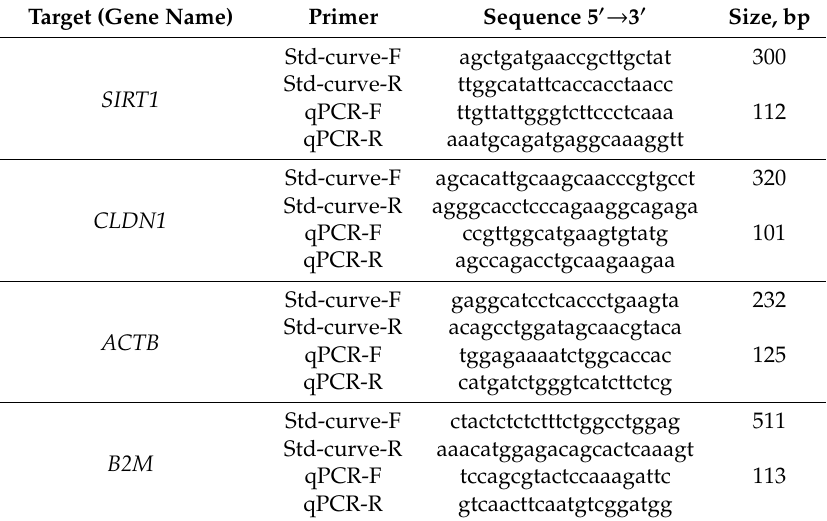
Table 2. Primer sequences for real-time polymerase chain reaction (RT-qPCR)